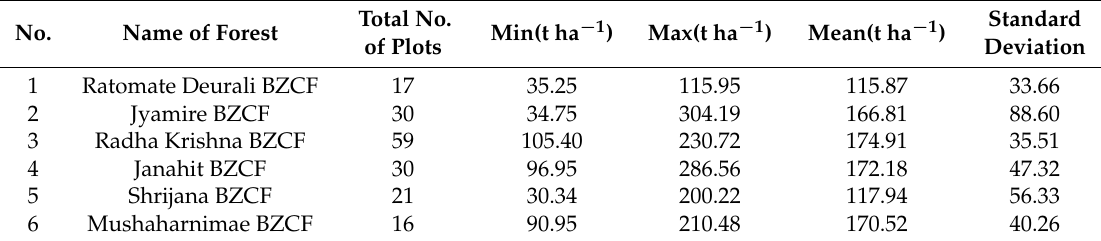
Table 3. Descriptive statistics of plot-level aboveground biomass (AGB).